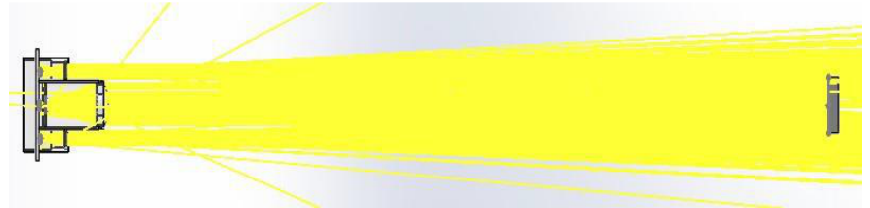
Figure 1. Light path diagram of optical